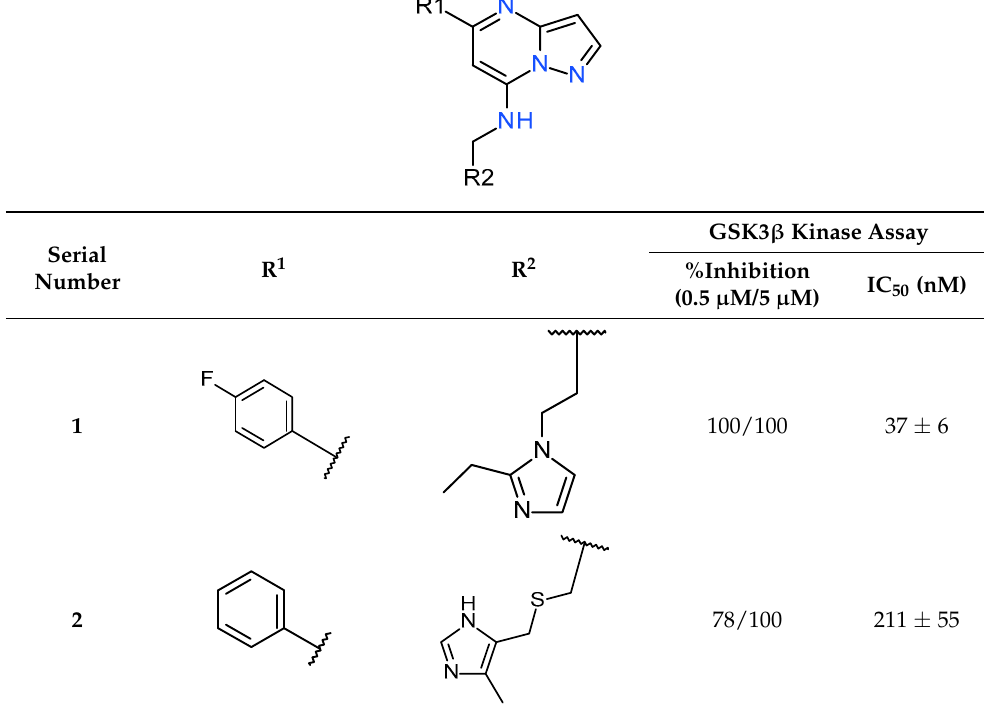
Table 1. GSK3 β inhibitory effects of derivatives of